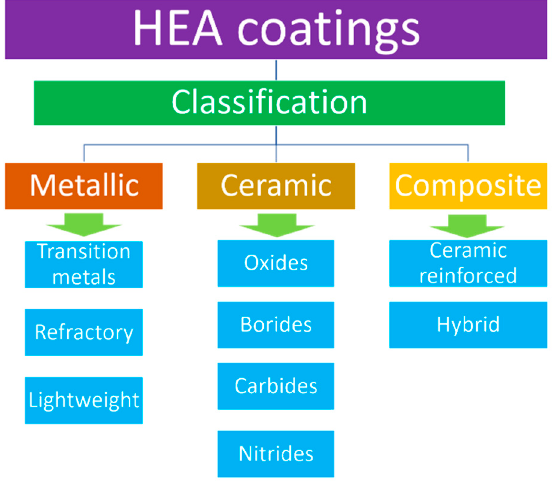
Figure 2. Various classes of HEA coatings.